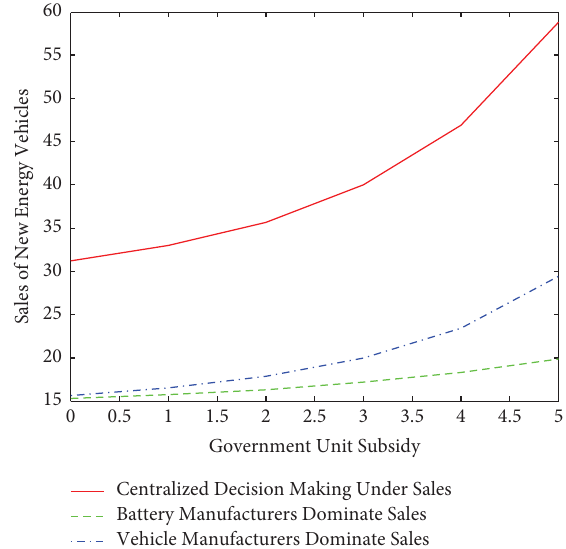
Figure 4: Te infuence of government subsidies on sales under diferent power